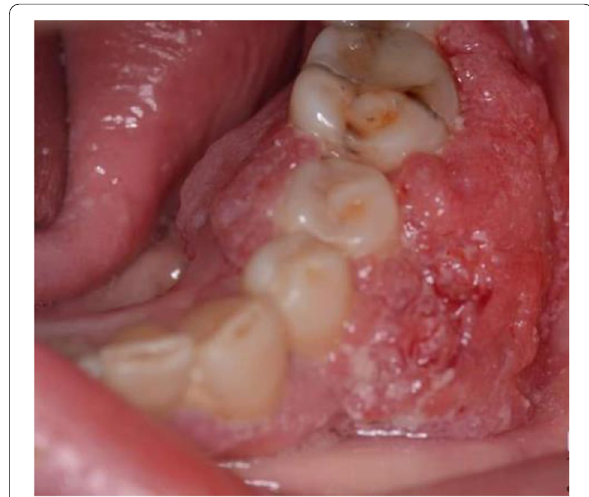
Fig. 1 Clinical presentation of a pinkish and red-white colored lesion with an exophytic “cobble-stone” surface